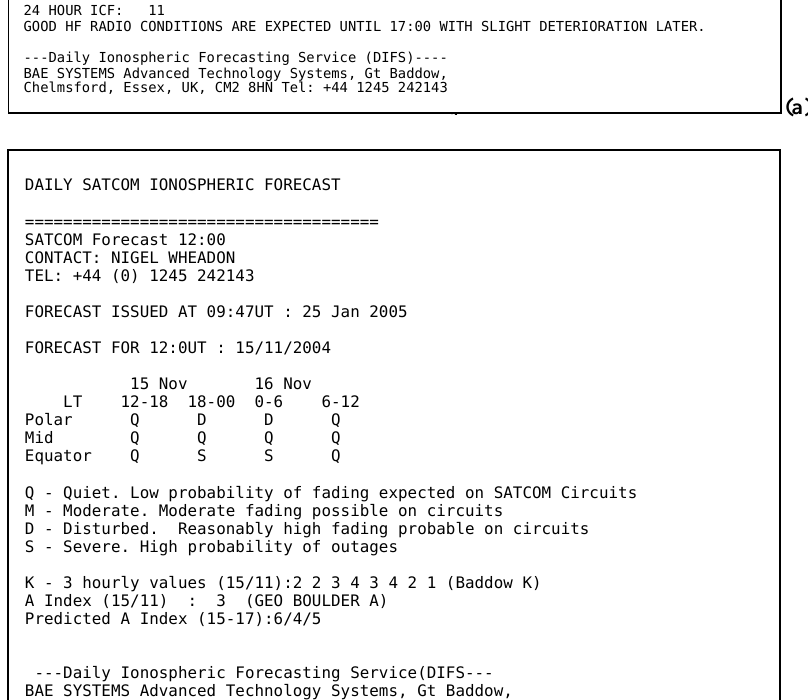
Fig 4-1 -HF Forecast for 24 th January 2005